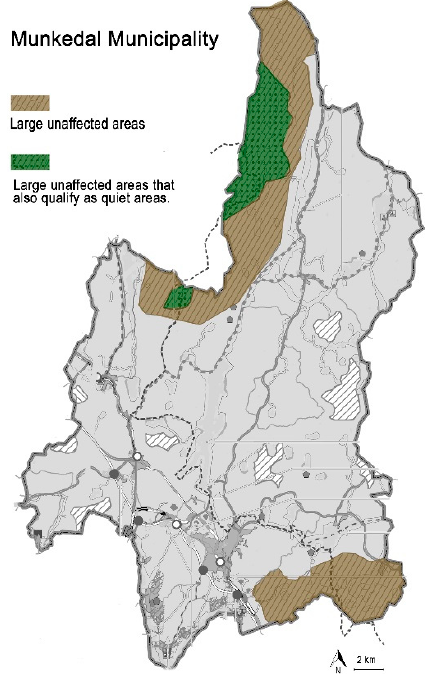
Figure 2. Map of Munkedal municipality, where “quiet areas” overlap with “large unaffected areas”. Adapted and translated from Munkedal’s general plan ÖP14 [32].